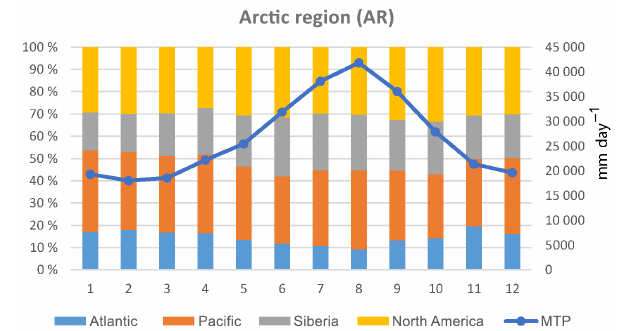
Figure 4. Seasonal cycle of moisture transport for precipitation (MTP) to the Arctic region (AR) from the four major sources (At- lantic, Pacific, Siberia, and North America). Values at the right rep- resent absolute values of transport, and those at the left indicate the relative contribution of each source by